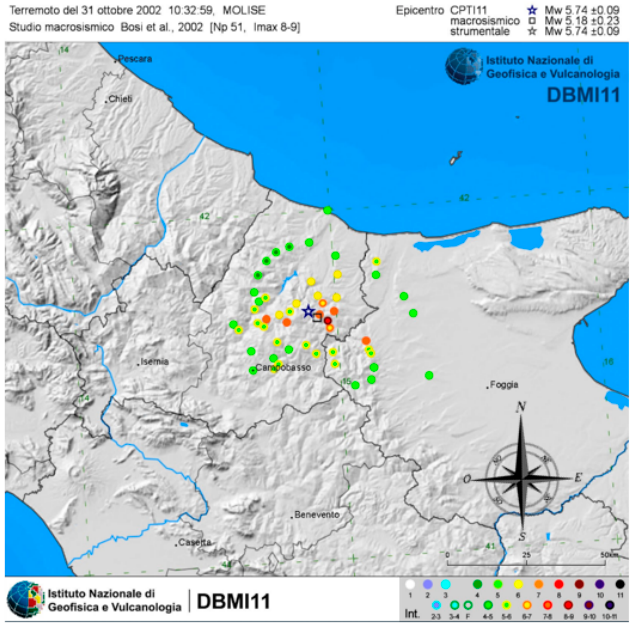
Figure 2. Distribution of earthquake intensities occurring on Thursday, October 31st 2002 [22].